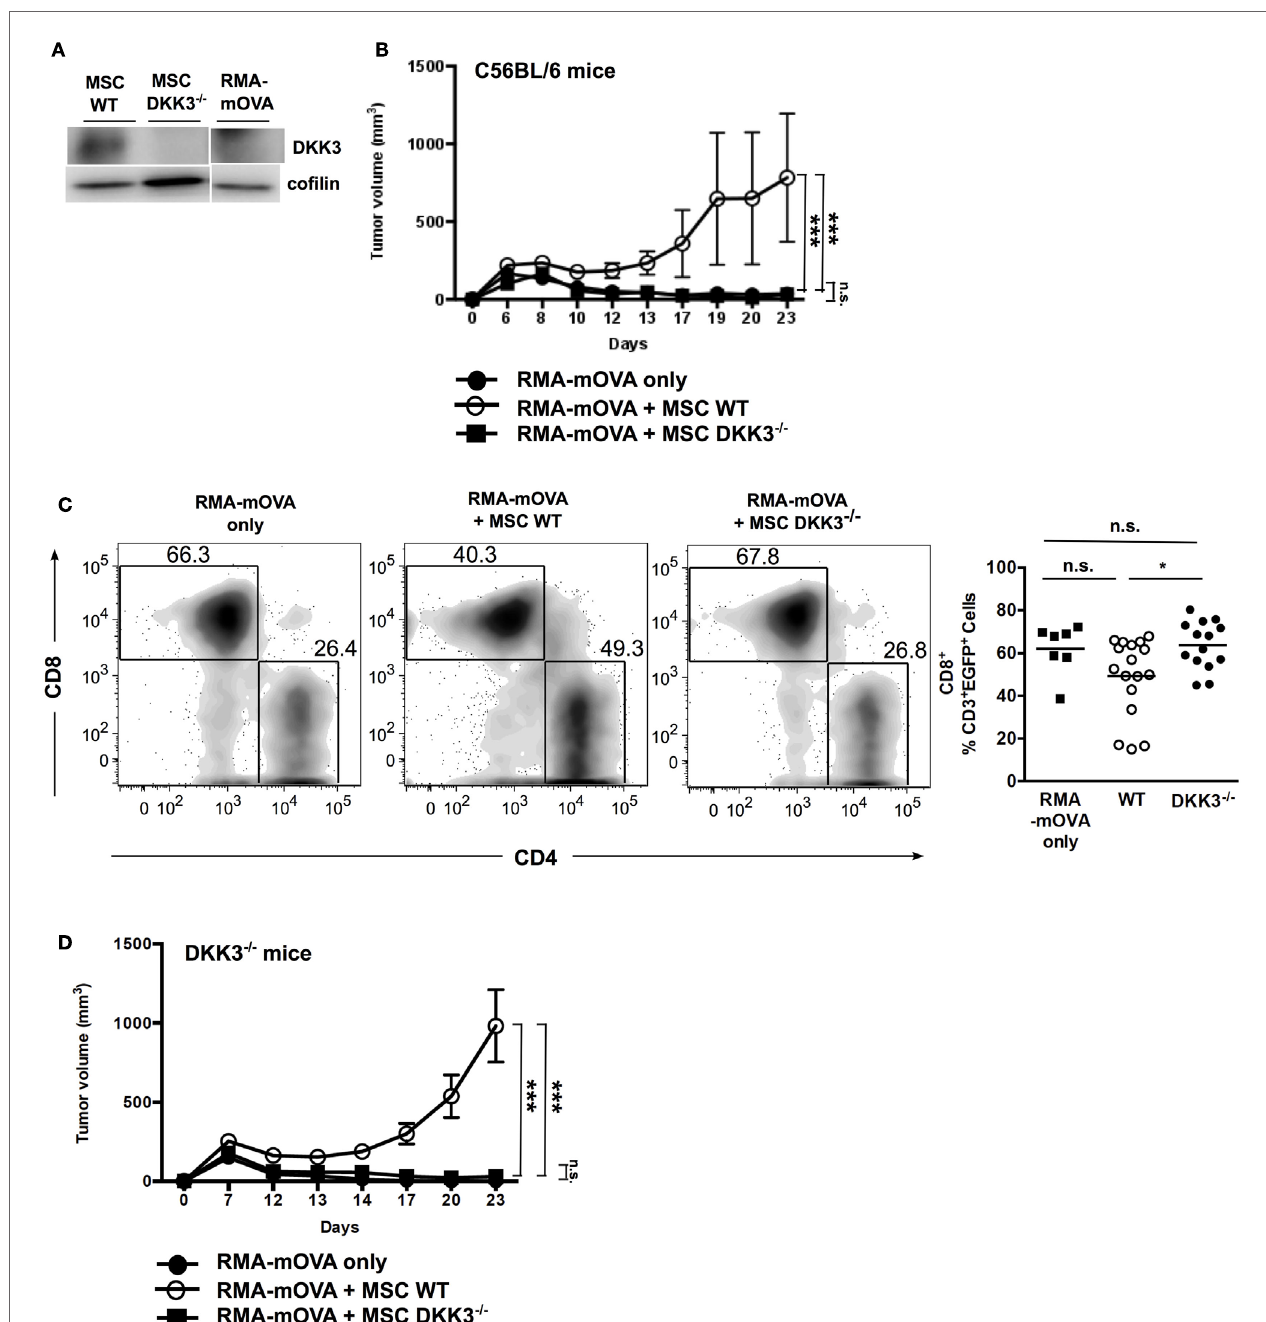
FigUre 3 | DKK3 expression exclusively by Mscs is sufficient to limit T cell responses against the strongly antigenic rMa-mOVa tumor . When inoculating 4 × 10 5 RMA-mOVA tumor cells, which did not express autologous DKK3 (a) , along with equal cell number of MSCs, (B) tumors with wild-type DKK3-competent MSCs ( ⚪ , n = 6) kept significant growth without rejection in comparison with tumors containing DKK3-deficient MSCs ( ▪ , n = 6) or without any MSC ( ⚫ , n = 6) ( p < 0.0001 or p < 0.0001). No difference in tumor growth could be distinguished between tumors with DKK3 − / − MSCs and tumors without any MSC ( p = 0.8516). (c) By inoculating RMA-mOVA cells with either wild-type ( ⚬ , n = 17) or DKK3 − / − MSCs ( ⚫ , n = 14) or without any MSC ( ▪ , n = 7) into EGFP + B6 mice, tumor-infiltrating immune cells in the isolated tumor nodules were identified as EGFP + cells after 14 days. Tumor-infiltrating CD8 + T cells were significantly increased in DKK3 − / − MSC-inoculated tumors in comparison with tumors with wild-type MSCs ( p = 0.0314). No difference was observed between tumors only and tumors containing either WT or DKK3 − / − MSCs ( p = 0.1190 or p = 0.8186). Two independent experiments were performed. (D) In DKK3 − / − mice, growth of RMA-mOVA tumors was only observed when tumor cells were co-injected with DKK3-competent MSCs ( ⚬ , n = 6), which was in contrast to tumors inoculated with DKK3-deficient MSCs ( ▪ , n = 6) or without any MSC ( ⚫ , n = 6) ( p < 0.0001 or p < 0.0001). No difference in tumor growth was observed between tumors harboring DKK3 − / − MSCs and tumors without any MSC ( p = 0.4166). ANOVA followed by the Holm-Šídák approach to multiple comparisons was